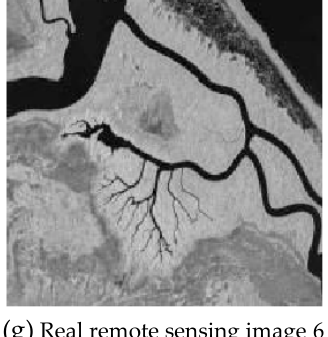
Figure 14. Real remote sensing images.